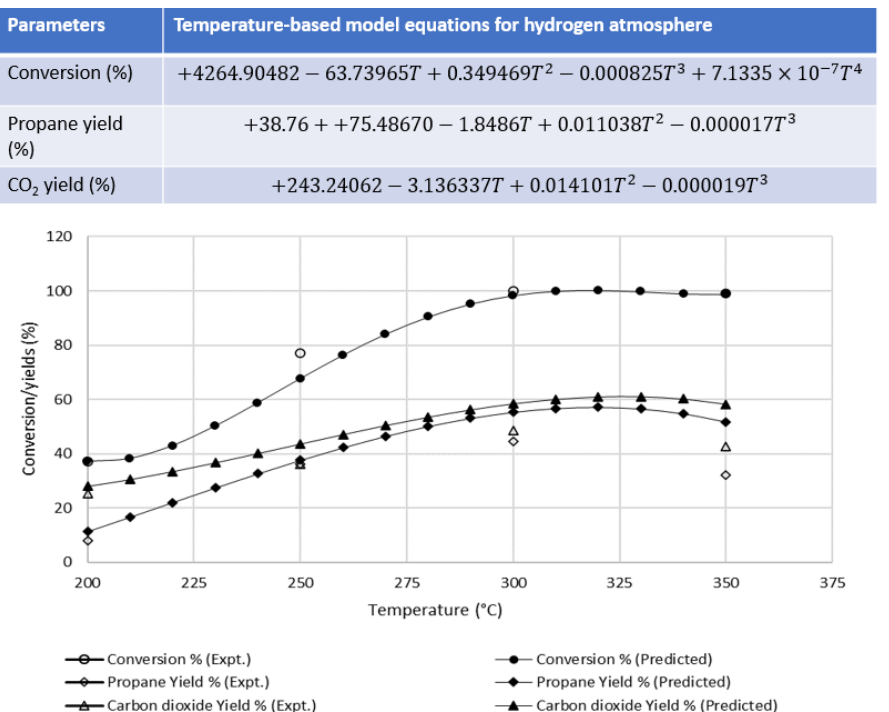
Figure 3. Comparisons between experimental and temperature-based model equations on butyric acid conversion and yields of propane and CO 2 under initial pressure of 5 bar hydrogen.